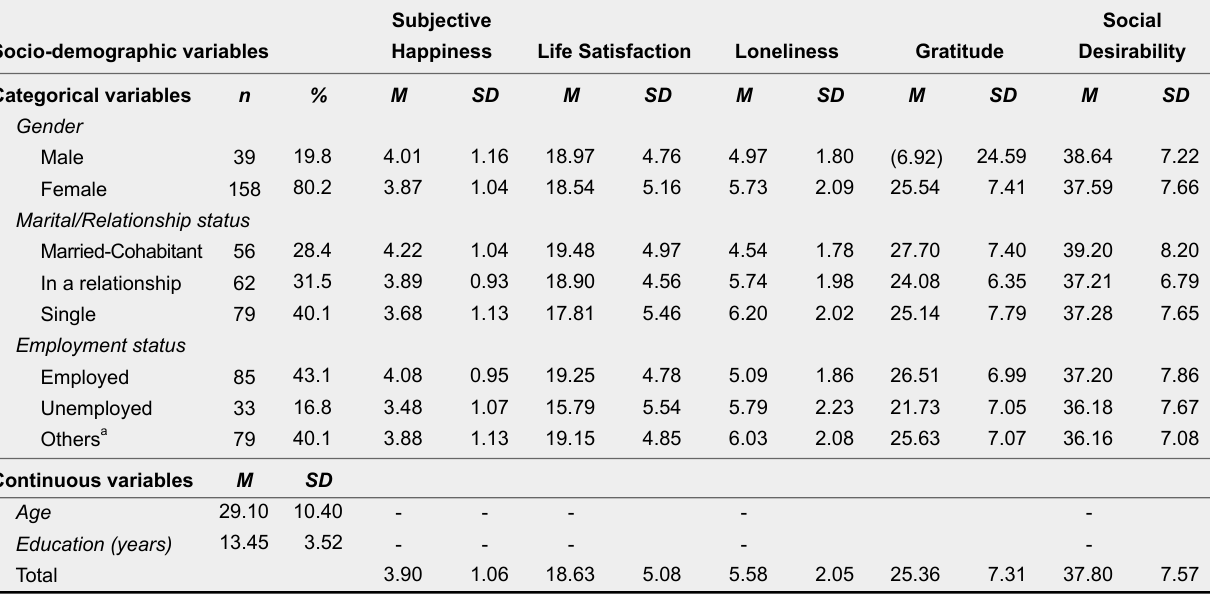
Socio-Demographic Variables and Descriptive Characteristics of Subjective Well-Being Measures of the Sample (N = 197)